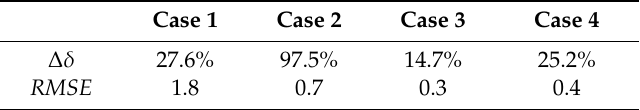
Table 4. The relative error ( ∆ δ ) and root mean square error (RMSE) between the integrated model simulated values and observed values of cases